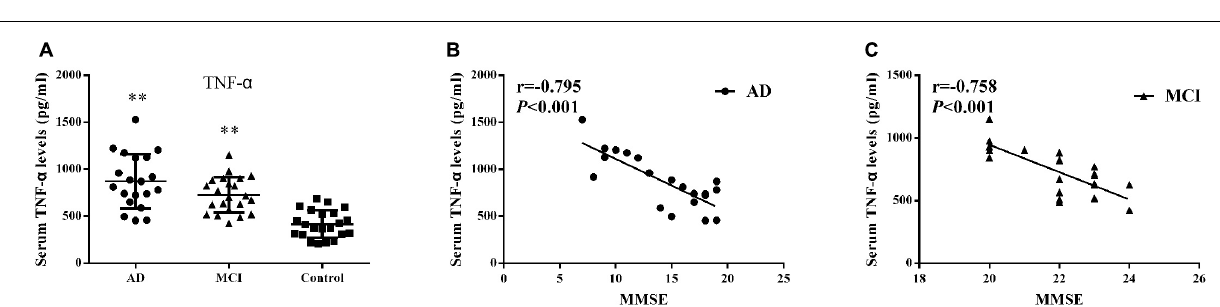
these results failed to achieve statistical significance.